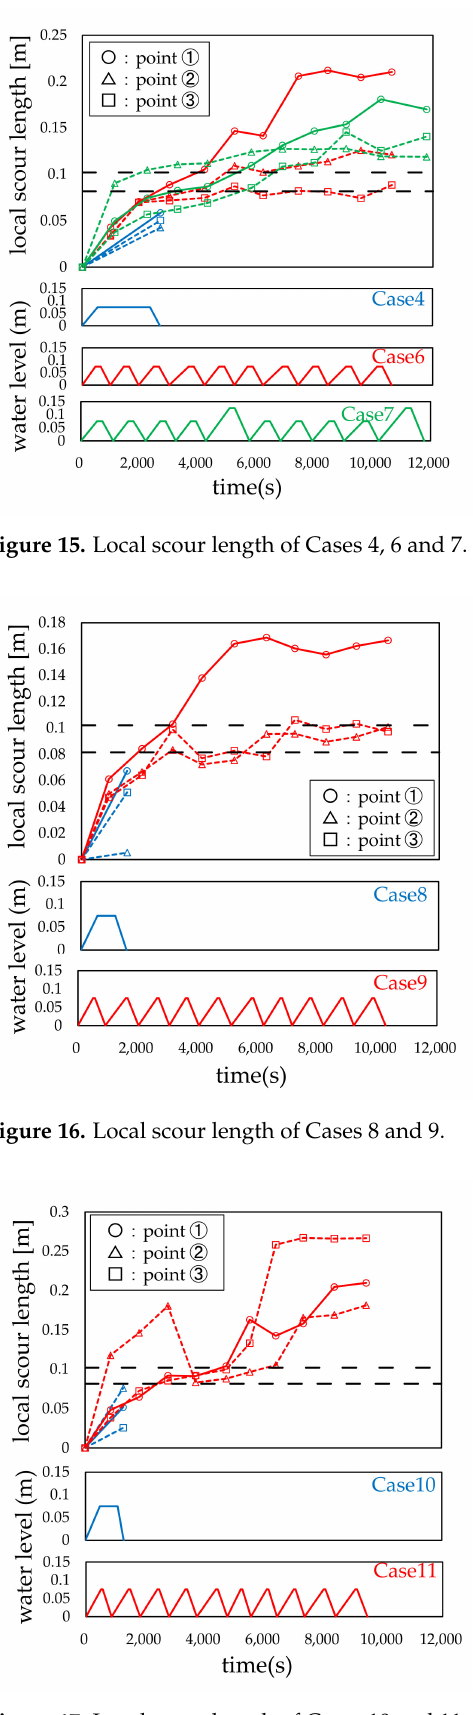
Figure 17. Local scour length of Cases 10 and